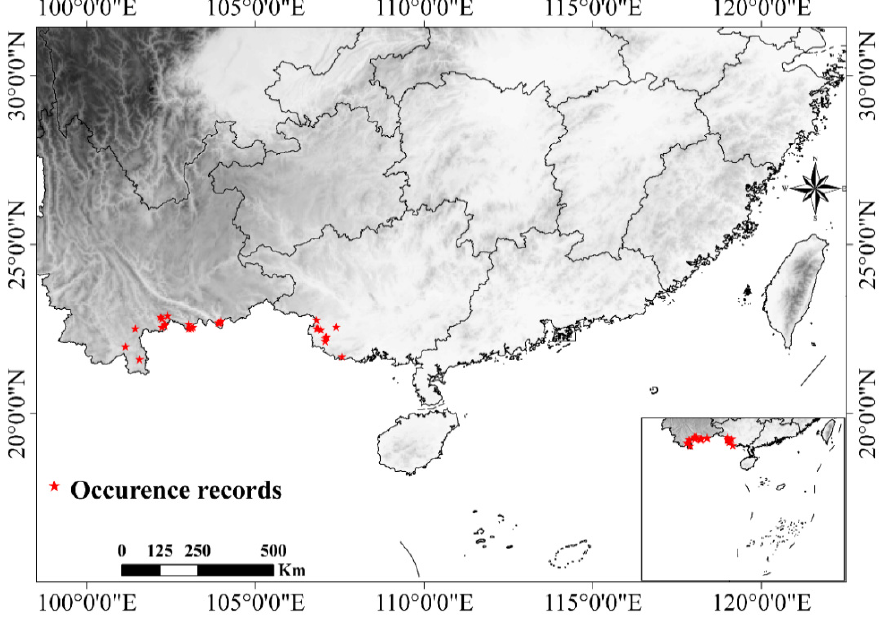
Figure 1. Map of localities where samples of the Horsfieldia tetratepala were employed for this study.